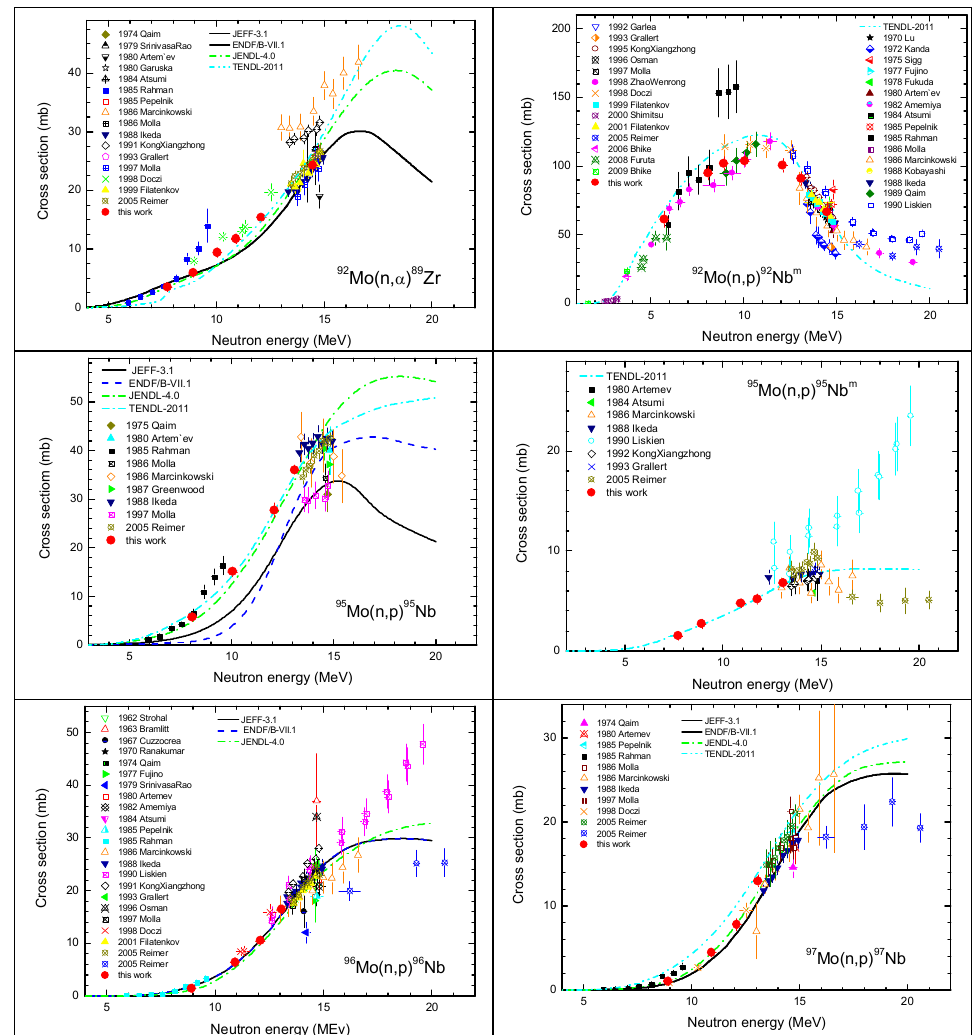
Figure 1. Experimental results for the indicated reactions compared with results from other authors and Evaluated Nuclear Data